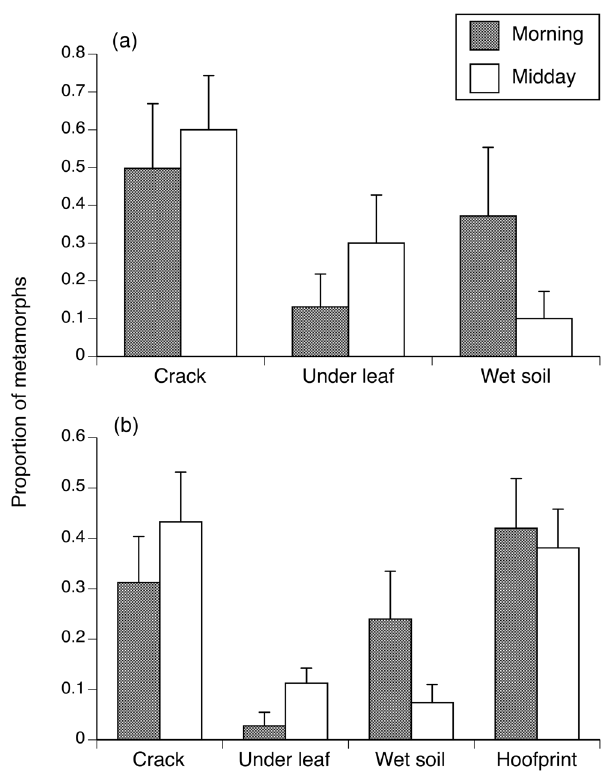
Figure 3. Proportion of metamorph cane toads (mean + 1 SE) using different microhabitats in field enclosures. The panels show proportions with no hoofprints (a) and with hoofprints present (b). Dark bars show data collected during morning surveys, whereas